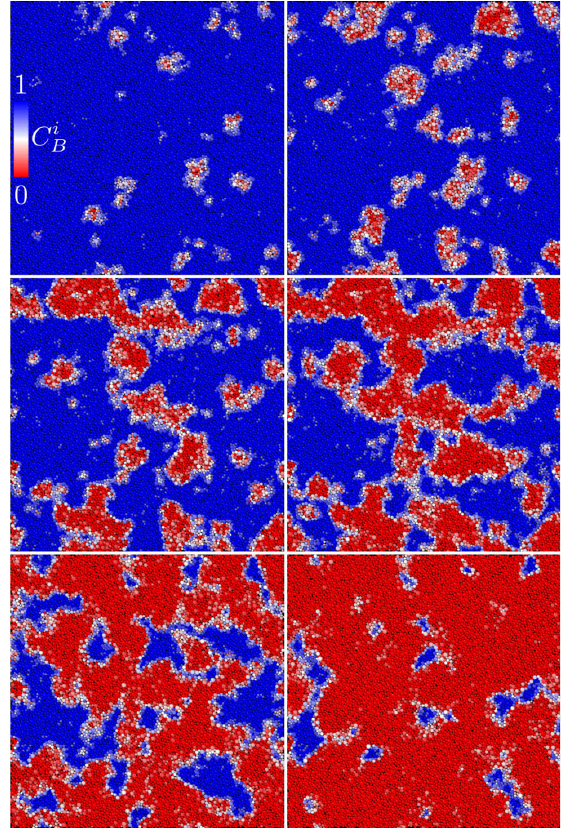
FIG. 4. Thirty milliseconds in the life of a supercooled liquid. Spatiotemporal evolution (left to right, top to bottom) of the structural relaxation in a 2D deeply supercooled liquid at T ¼ 0 . 09 , where τ α ¼ 1 . 5 × 10 8 . Particle colors indicate the bond-breaking correlation C i ð t j Þ from blue (quiescent) to red B (mobile) following the color bar indicated top left. The snapshots are taken at times t 1 ; … ; t 6 ¼ 2 × 10 6 , 10 7 , 4 . 6 × 10 7 , 1 . 1 × 10 8 , 2 . 3 × 10 8 , 8 . 2 × 10 8 , at which the average bond-breaking corre- lation equals 0.97, 0.86, 0.7, 0.54, 0.33, and 0.1. The linear size of the box is L ¼ 100